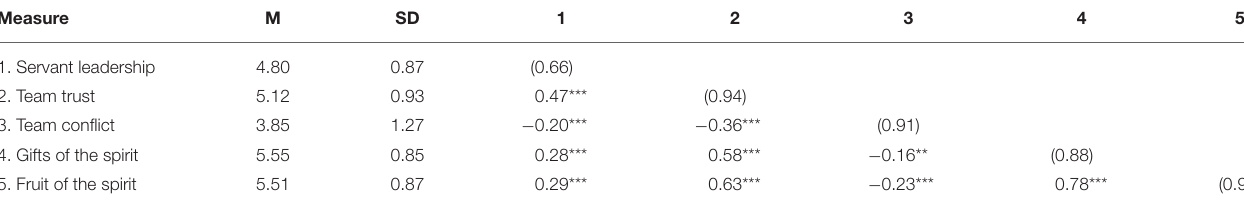
TABLE 3 | Means, SDs, correlations, and scale reliabilities of studied variables. Measure